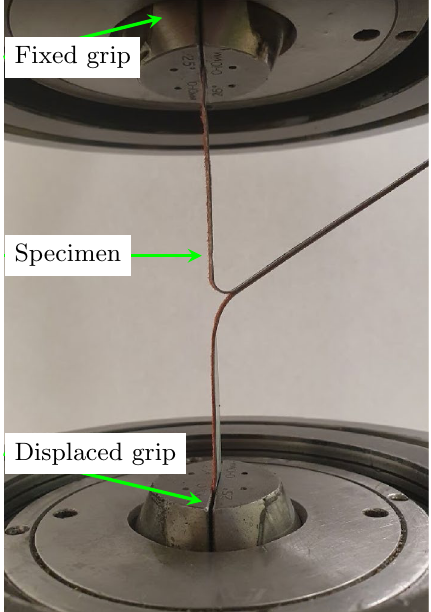
Fig. 10 Experimental setup for T-peeling test. The specimen is placed in the Instron 1272 testing machine with the upper grip being fixed and the lower displaced, peeling apart the sandwich specimen. During testing, stroke and load is